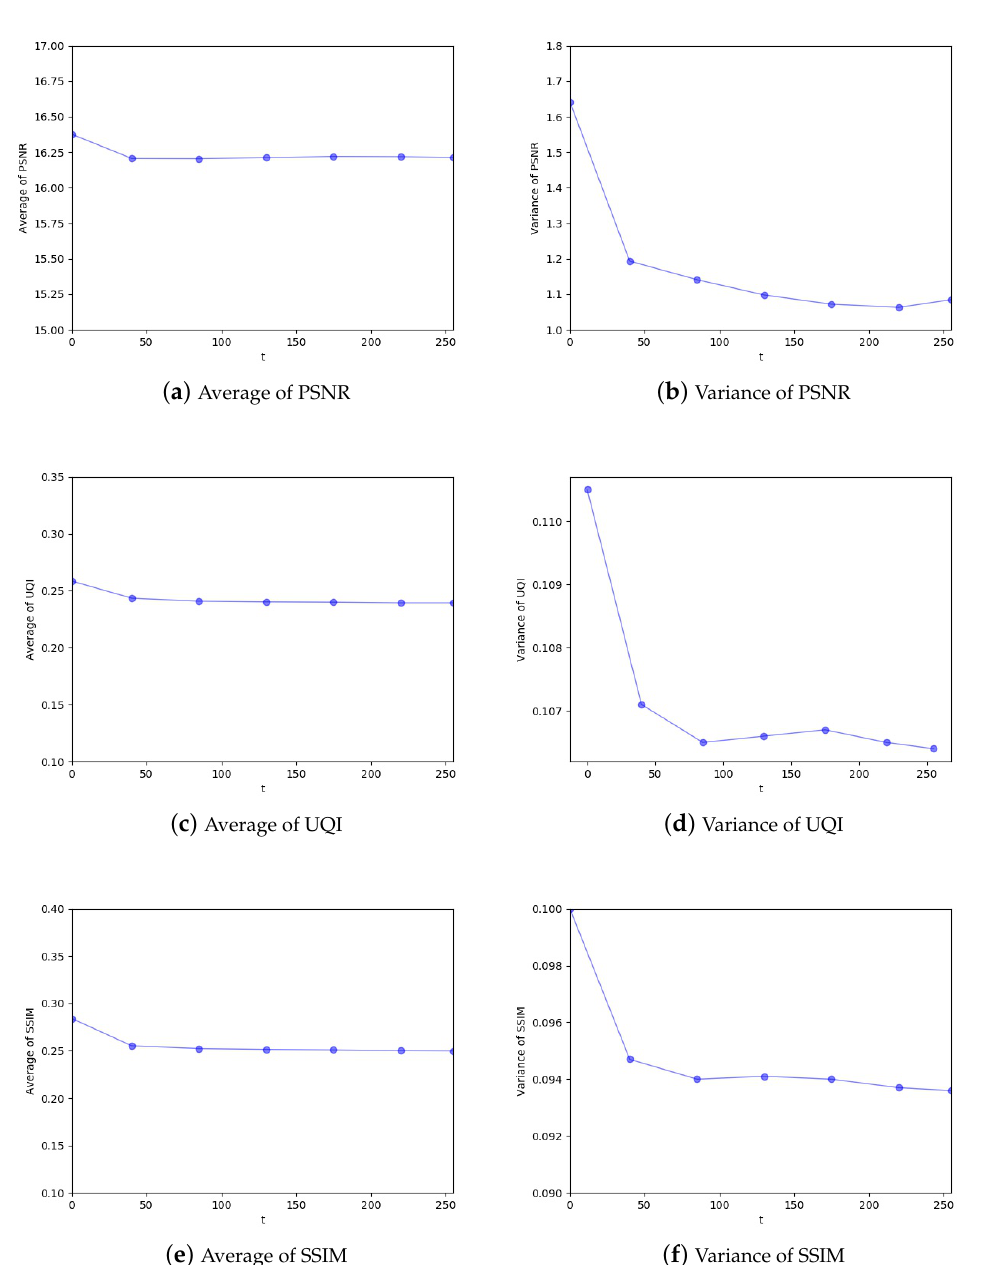
Figure 7. Metric results with different t values for (2,3) threshold; ( a , b ) average and variance of PSNR with different t values; ( c , d ) average and variance of UQI with different t values; ( e , f ) average and variance of SSIM with different t